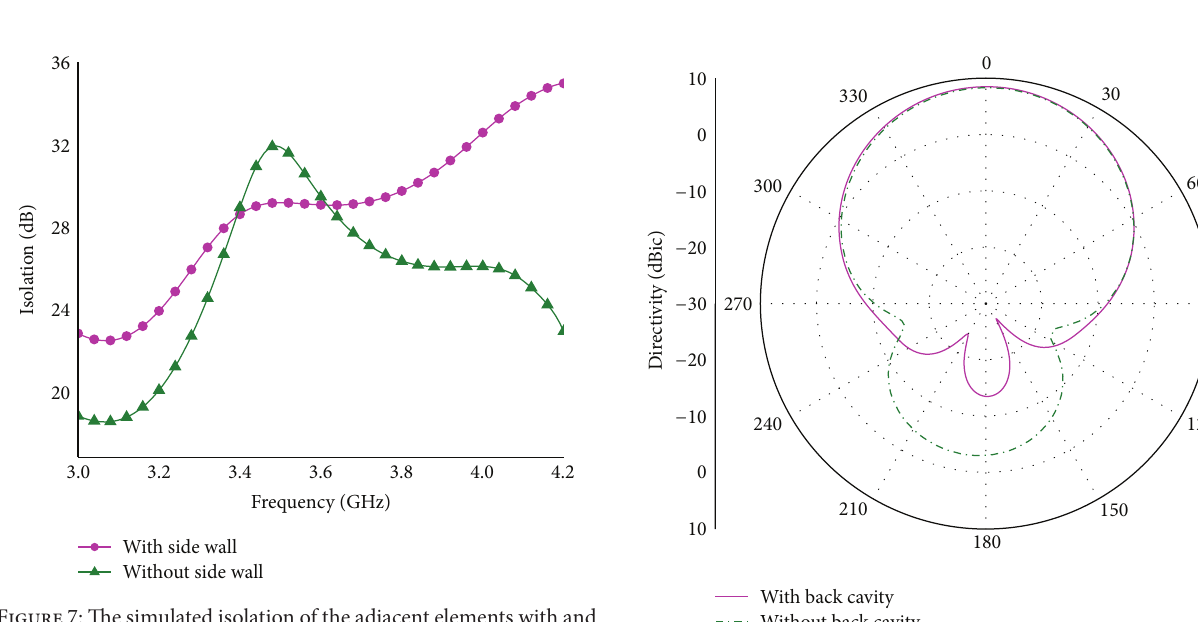
Figure 7: The simulated isolation of the adjacent elements with and without side wall in an array.